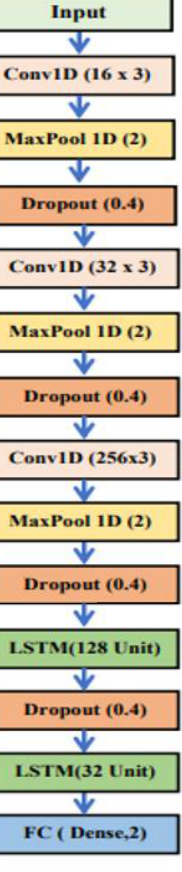
Figure 6. The suggested 1D CNN-LSTM model’s structure (time domain). Table 3. The structural design for deep learning algorithms in the time